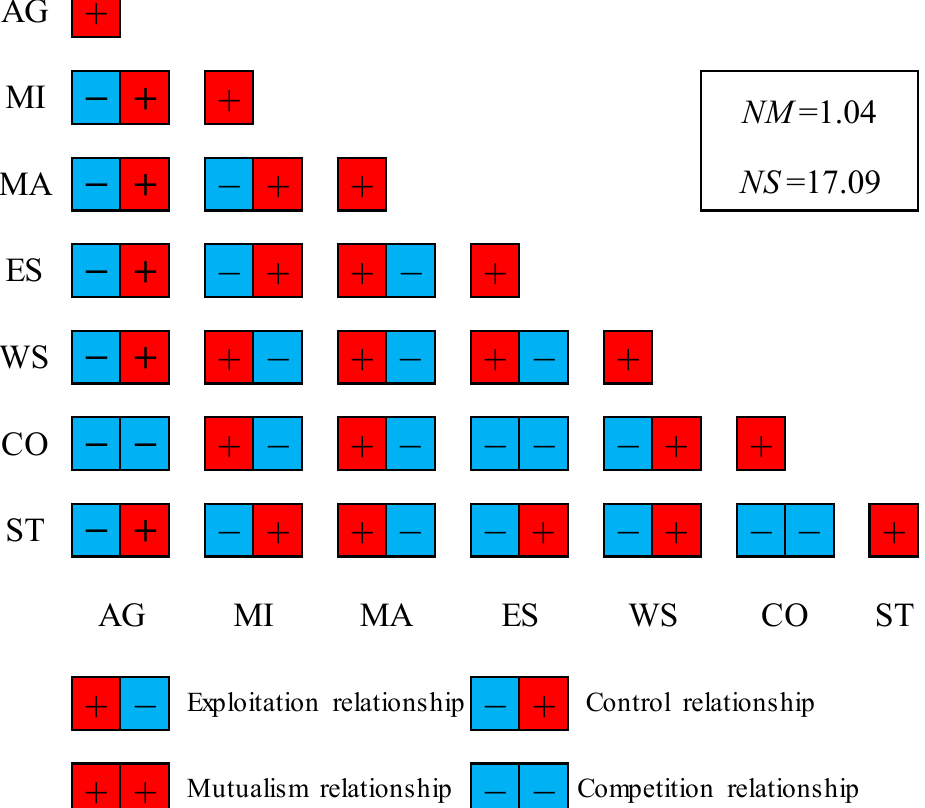
Figure 6. Integral mutual relationships in the virtual water system. (Notes: The integral utility relationships between each compartment are shown from the matrix column to the matrix row).